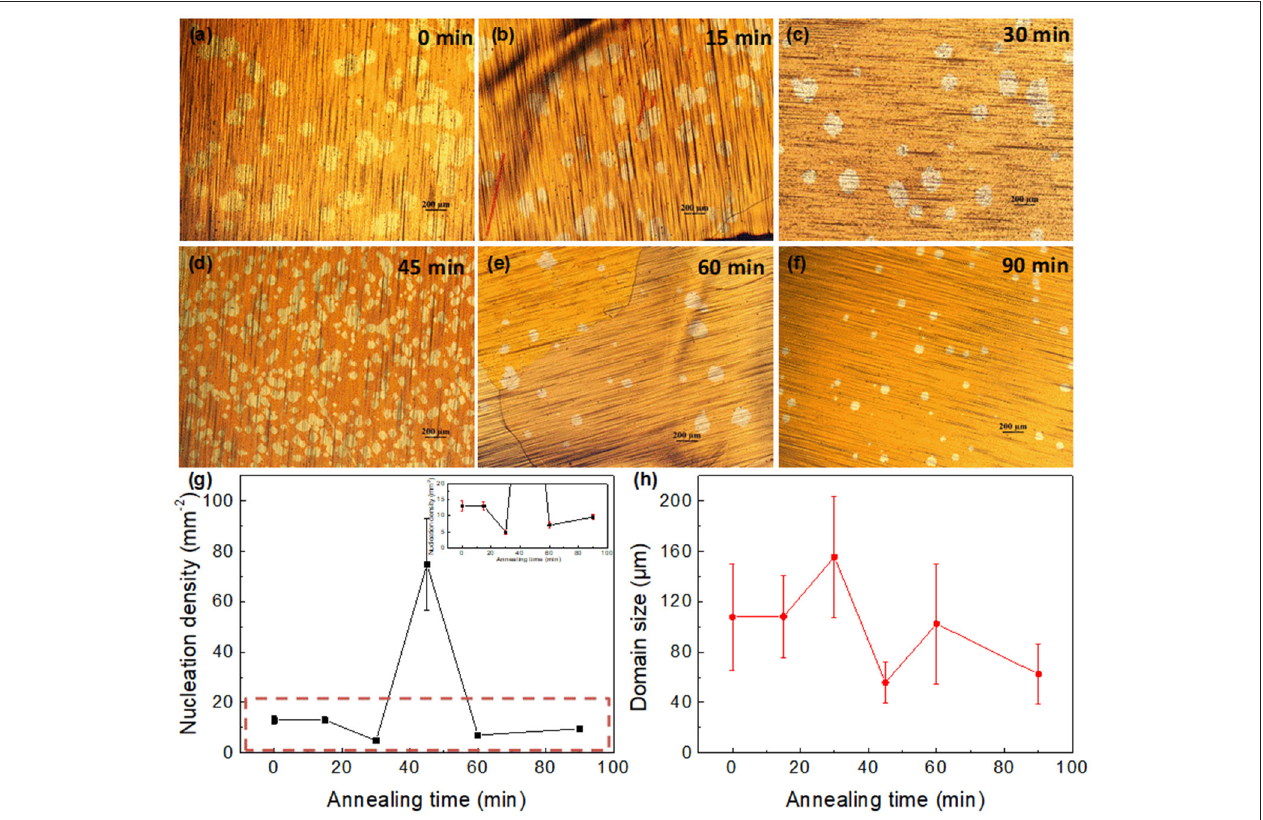
FIGURE 1 | (a–f) Optical images of graphene domains with 30 min growth on Cu foil pretreated with different annealing times in Ar/H 2 . (a) 0, (b) 15, (c) 30, (d) 45, (e) 60, and (f) 90min. (g,h) Dependence of (g) nucleation density, and (h) graphene domain size on the annealing periods. Inset in g is the enlargement of curves in the red rectangle, showing the error bars in different